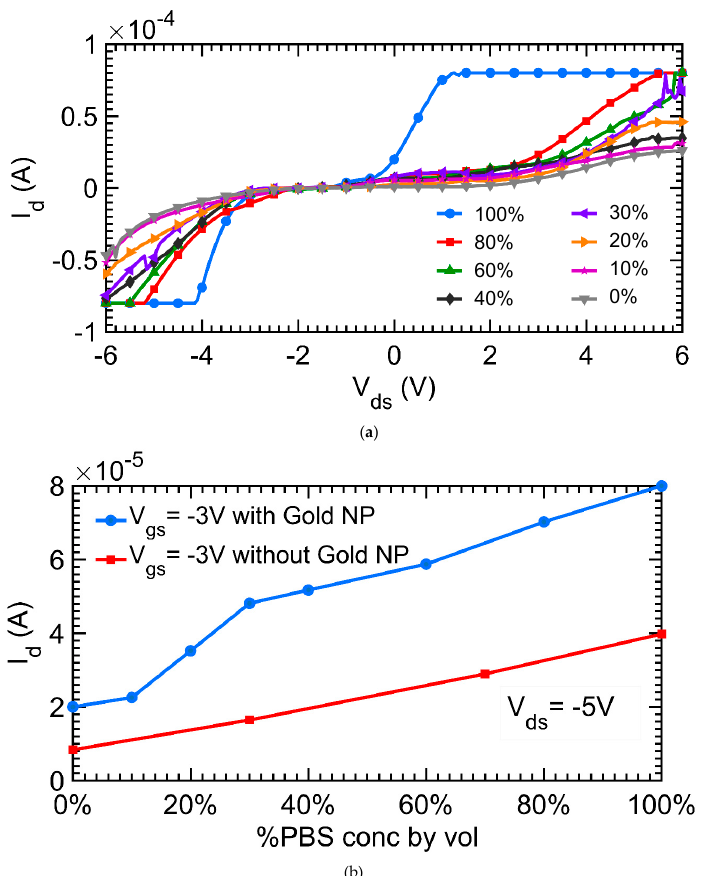
Figure 13. Chemical sensing with the hydrogel FET ( a ) I d -V ds plot of the hydrogel with Au-NP device with various concentrations of PBS in DI water by volume at V gs = − 3 V and V ds = − 6 V to +6 V ( b ) I d at V ds = − 5 V for different concentrations of PBS by volume for V gs = − 3 V.